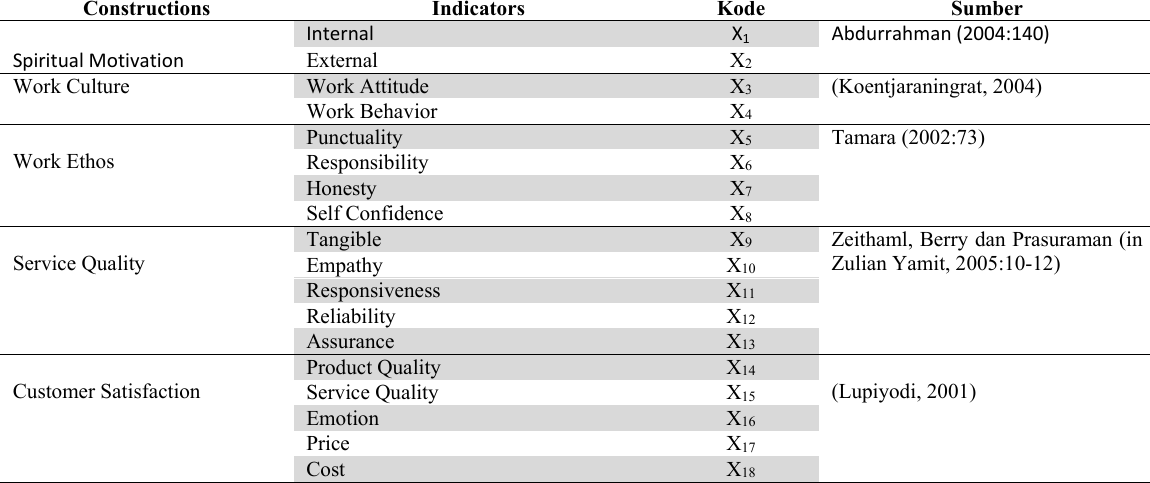
Definition of research variable